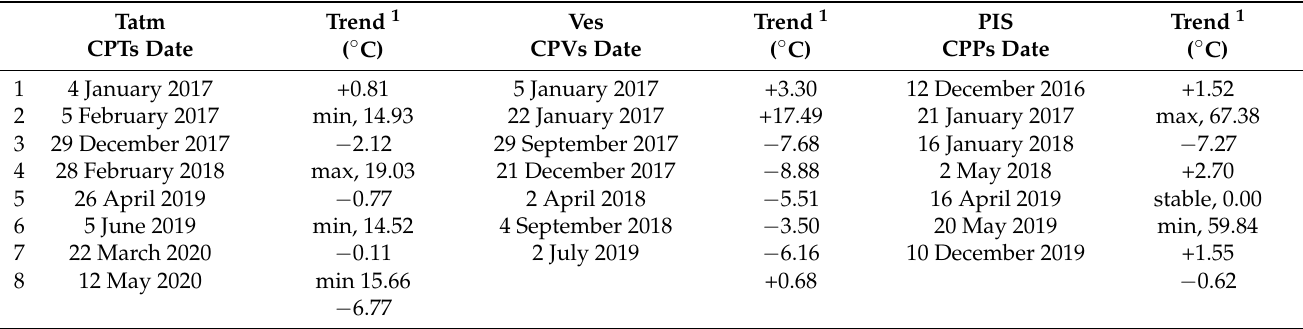
Table 2. Changing Points of T atm (CPTs), VES (CPVs) and PIS (CPP) time-series. The minus/plus signs indicate decreas- ing/increasing trends. The trend is referred to the linear trend between CPs, in °C.